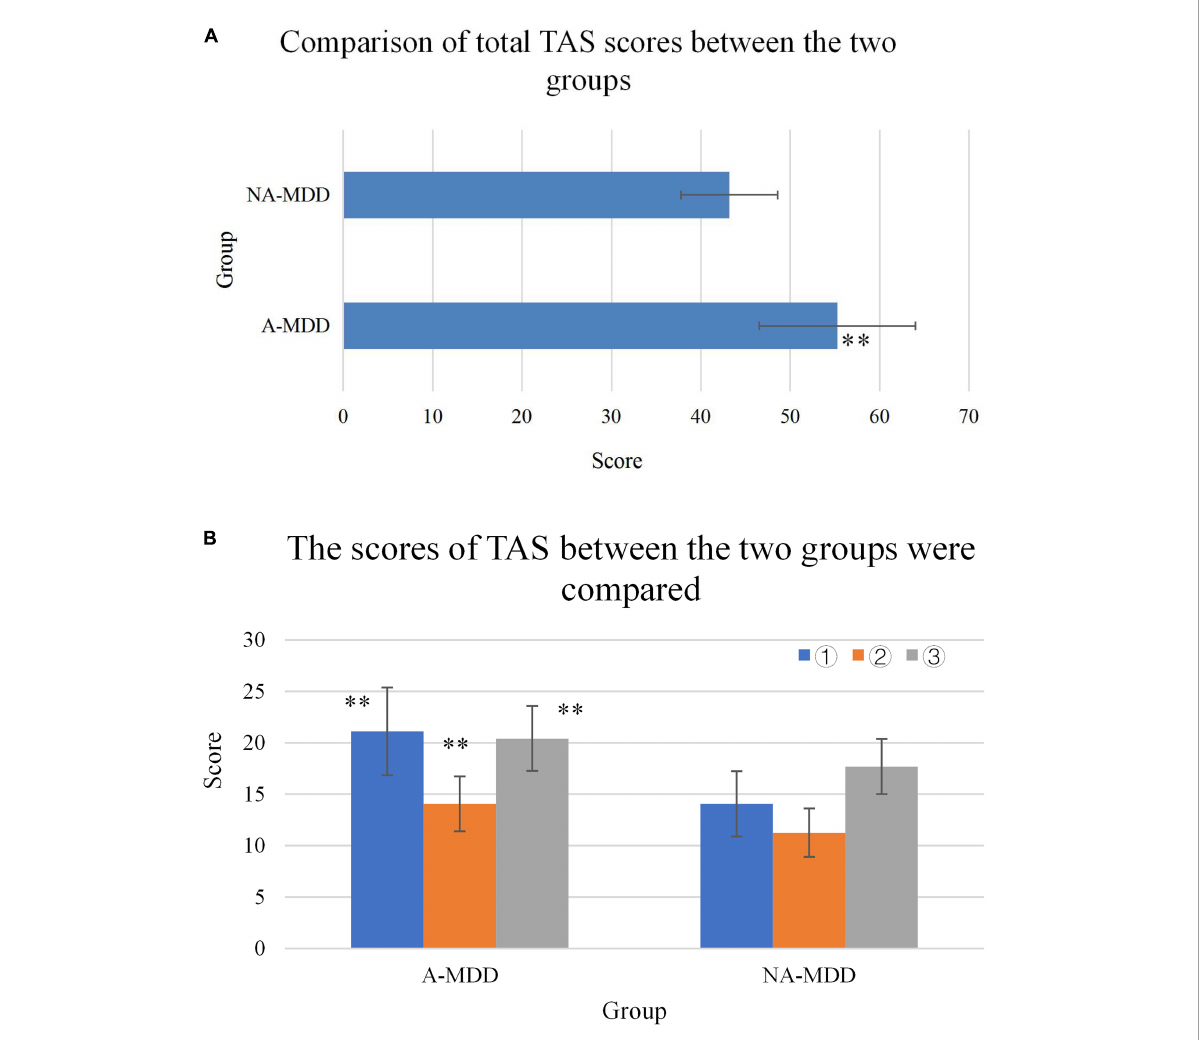
FIGURE9 (A) Comparison of TAS scores between the two groups. (B) ∗∗ Represented a very significant difference compared with the NA-MDD group ( P <